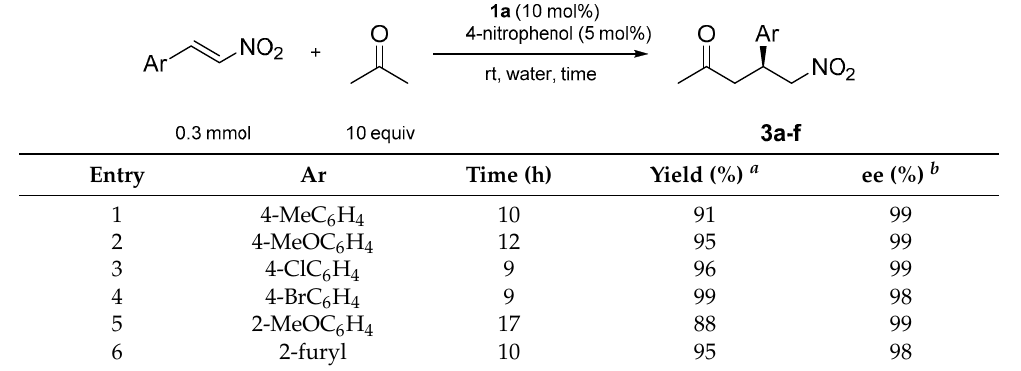
Table 2. Reaction of acetone with α , β -unsaturated nitroalkenes.